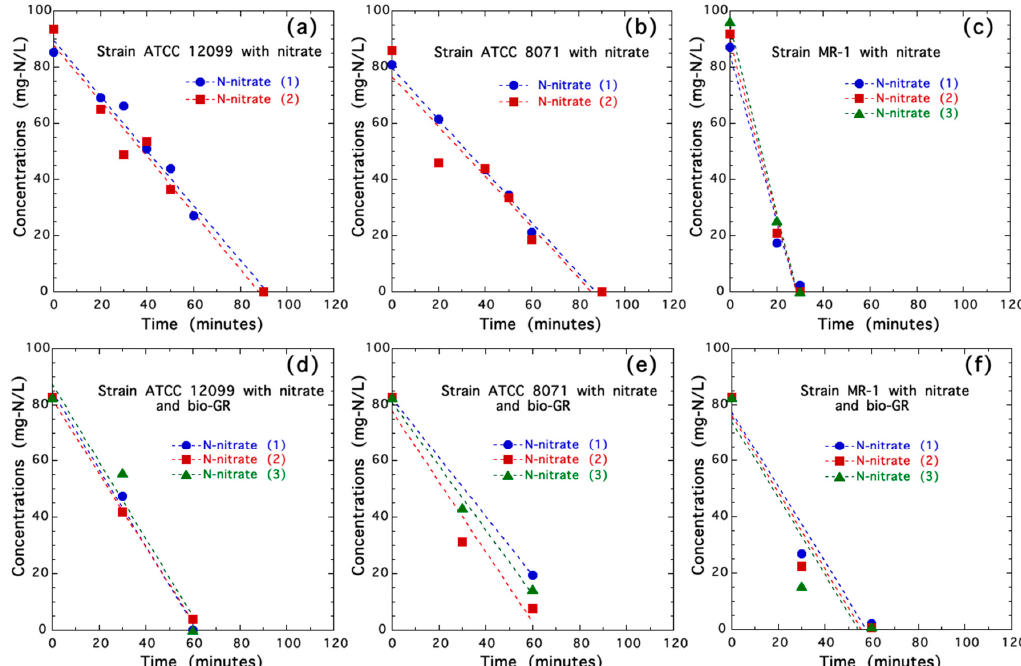
Figure 4. Abiotic nitrate (in blue) interaction with biogenic iron(II-III) hydroxycarbonate green rust at ( a ) pH 6.5; ( b ) pH 7.5 and ( c ) pH 10.0. Fe(II)tot (in black) corresponds to the total Fe(II) concentration measured by the 1,10-phenanthroline colorimetric analysis after 0.5 M HCl extraction. Fe(II)aq (in orange) corresponds to the dissolved Fe(II) concentration measured by the 1,10-phenanthroline colorimetric analysis in samples filtered through the 0.22 µm pore size filters. Experimental data were fit using a linear regression fitting procedure (dashed lines).